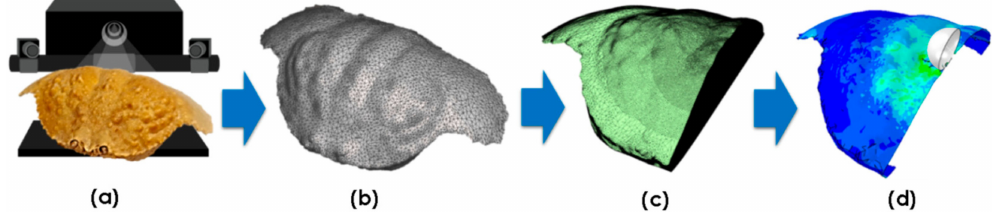
Figure 3. 3D scan to FE analysis process: ( a ) point cloud data is obtained and processed; ( b ) surface mesh is edited; ( c ) orphan mesh suitable for FE analysis is generated; ( d ) FE model is defined.